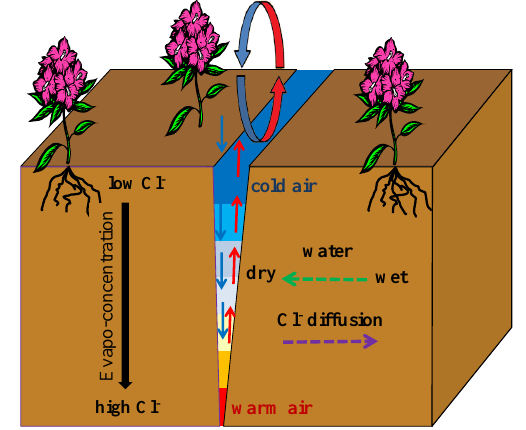
Figure 2. Desiccation-crack-induced salinization (DCIS), Baram et al. (2013). Convective instability of air in soil cracks, occurring mainly at night, leads to drying and salinization of the unsaturated